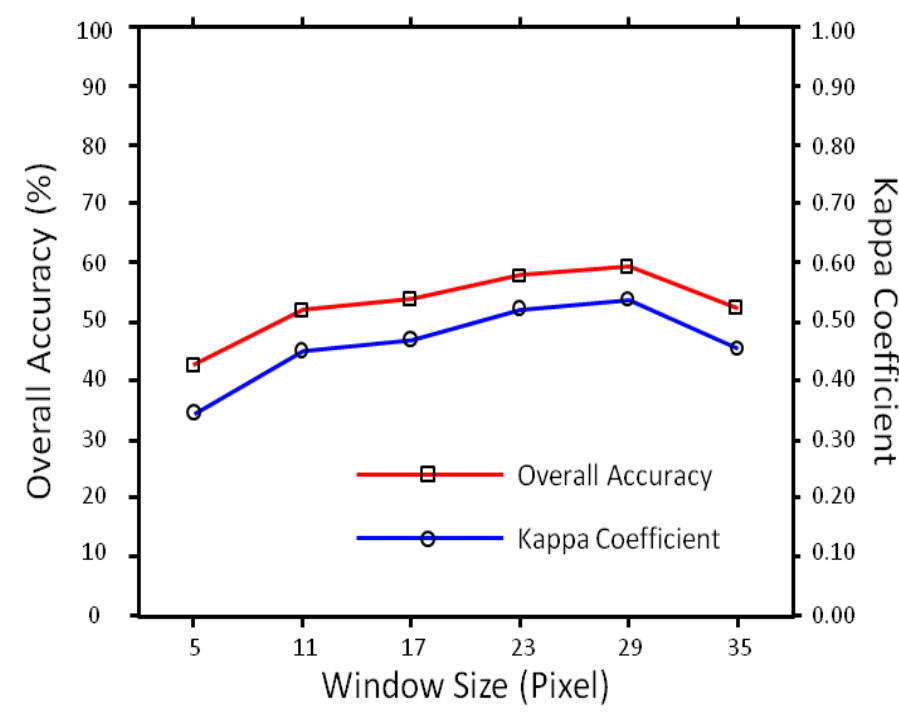
Figure 4. Accuracy of the classification results using each moving window